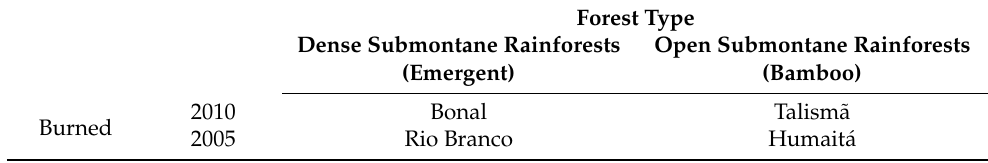
Table 1. Breakdown of the nuances of burned areas by forest type and year burned.